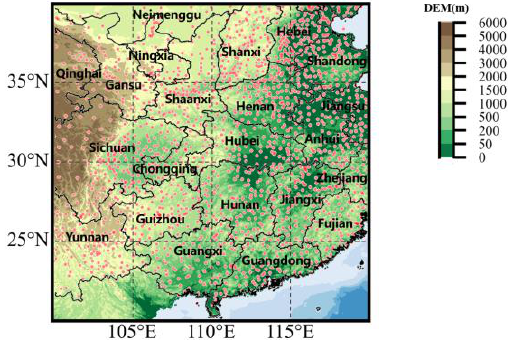
Figure 4. Geographic area involved in atmospheric visibility data set. The black line represents the provincial line, and the red points indicate the meteorological station from the China Meteorological Information